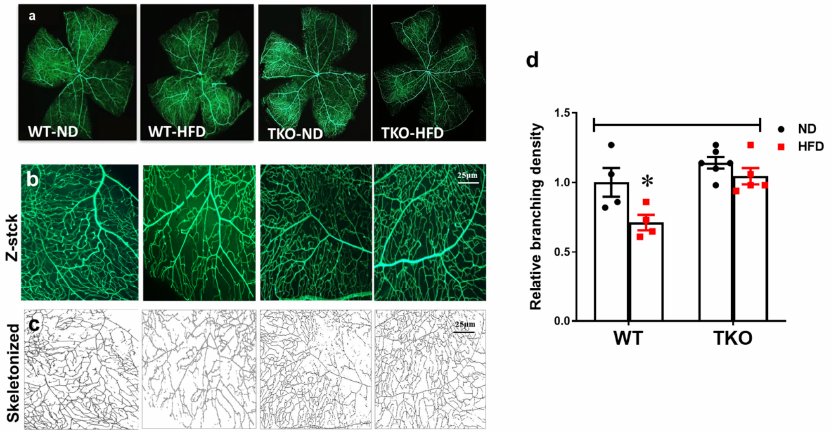
Figure 9. Deletion of TXNIP abrogates HFD-induced microvascular morphological changes. Representative images of ( a ) total retinal flat mounts stitched from individual lopes of the retina, ( b ) representative of a compressed Z-stack image of one of the retina loops and ( c ) skeletonized compressed images from each of the animal groups. ( d ) WT-HFD mice had decreased retinal vascular branching density compared with WT-ND control group. In contrast, TKO mice had a comparable morphological appearance compared to the WT-ND group that did not change in response to HFD. Two-way ANOVA showed significant interaction between the type of diet and genotype across microvascular density ( n = 4–6 mice/group; * p < 0.05 vs. other groups).